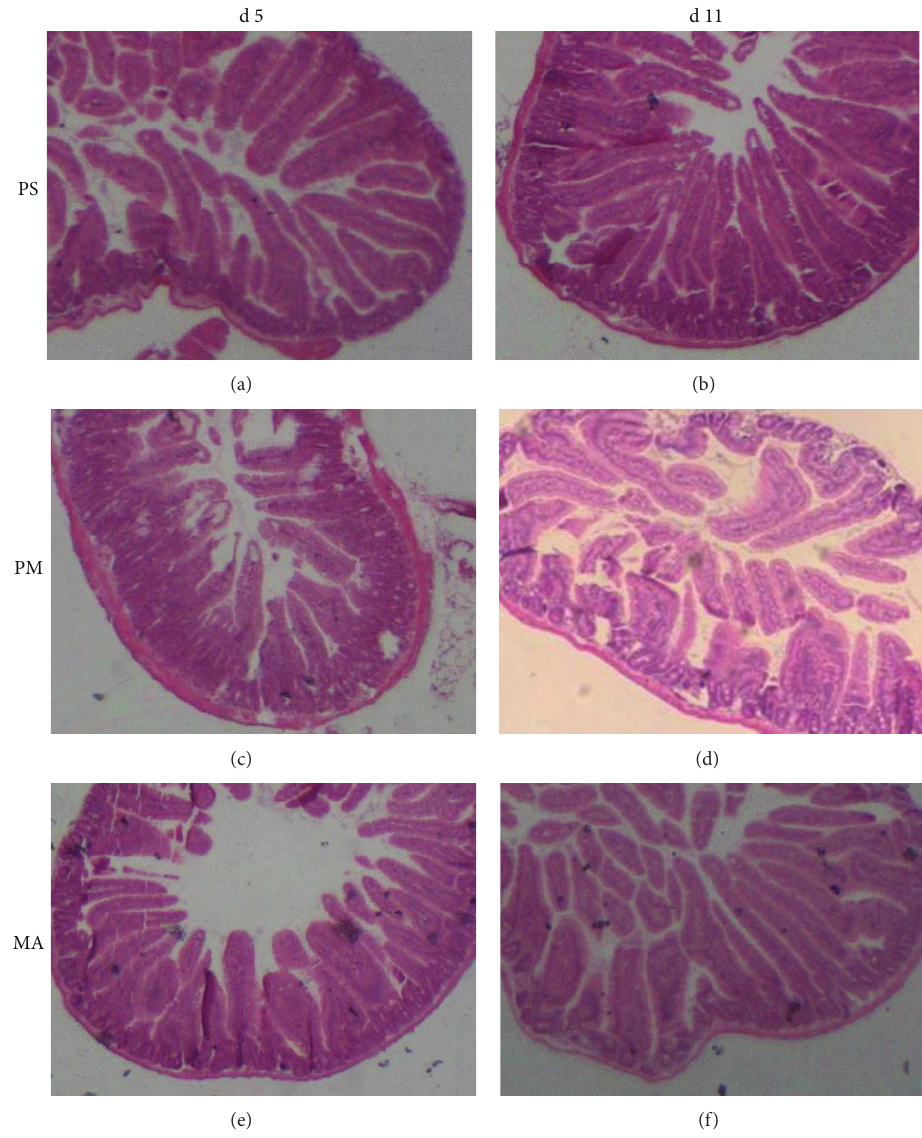
Figure 6: Histological sections of the jejunum stained with H&E taken at 20x magnification. Images (a) and (b) represent the PS group (control) for d 5 and d 11, respectively, with normal villi and crypts. Images (c) and (d) represent the PM group (MTX-treated) for d 5 and d 11, respectively; the administration of MTX was characterized by atrophy of the villi, increased crypt depth, and enterocyte disruption, predominantly on d 5. Images (e) and (f) represent the MA group (MTX-treated + acteoside) for d 5 and d 11, respectively; the administration of acteoside administration prevented villus and crypt damage on d 5 and d